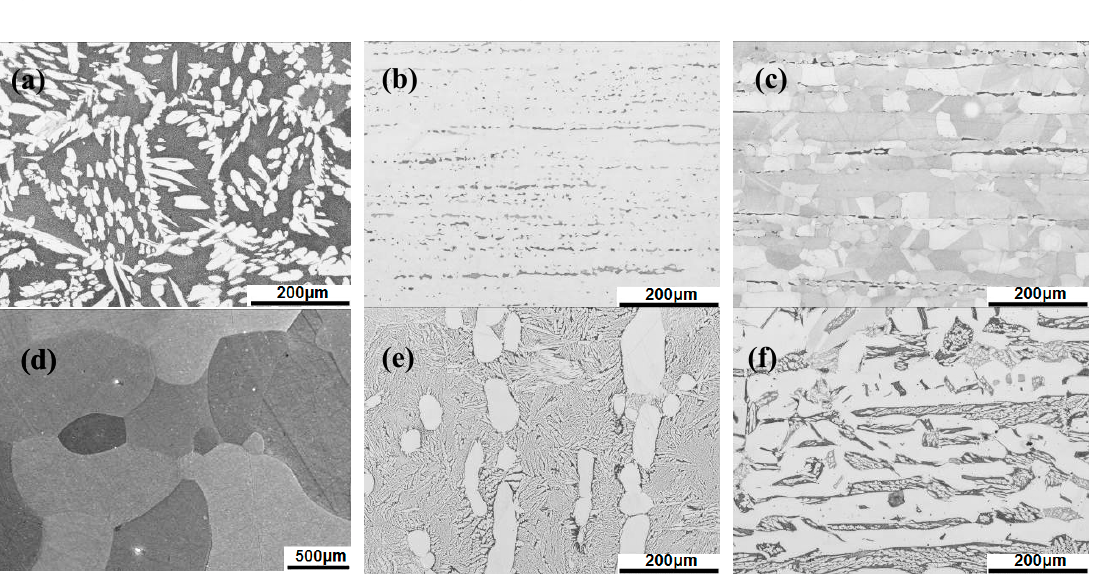
type helical chips, 5 ribbon chips.